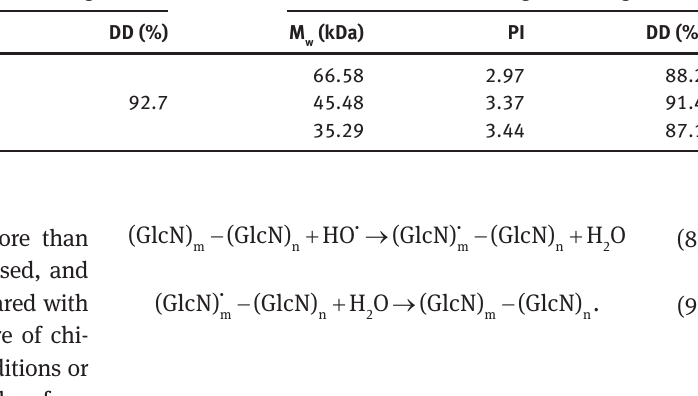
Table 1: Effects of the concentrations of H Samples Before heterogeneous